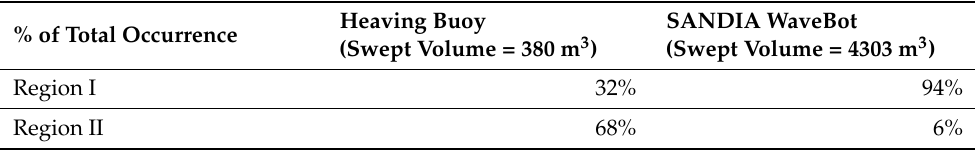
Table 2. Percentage of total sea state occurrence in Regions I and II for the heaving buoy and SANDIA WaveBot.